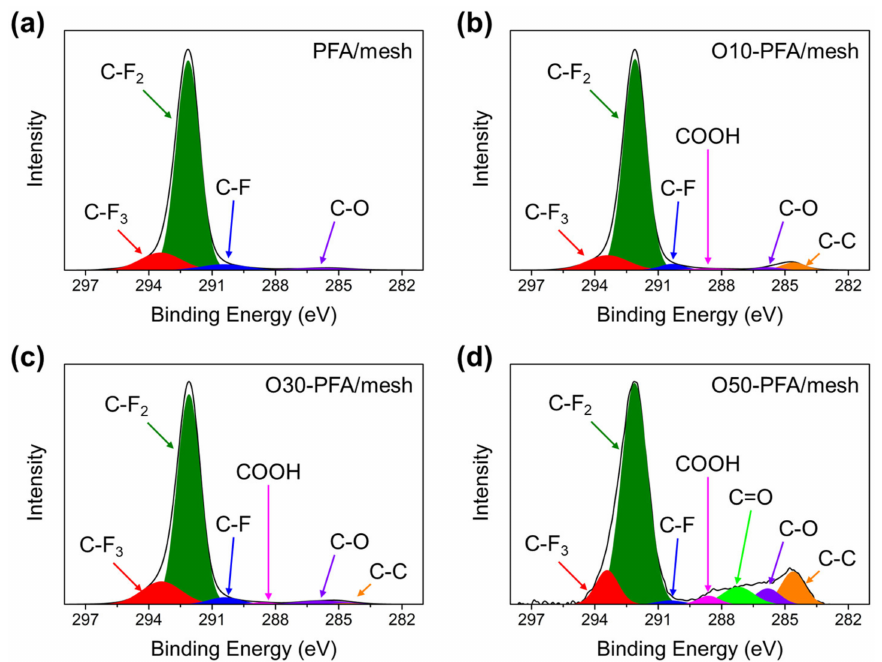
Figure 3. XPS spectra of stainless-steel mesh coated PFA before and after surface modification by oxyfluorination: ( a ) PFA/mesh, ( b ) O10-PFA/mesh, ( c ) O30-PFA/mesh, and ( d )